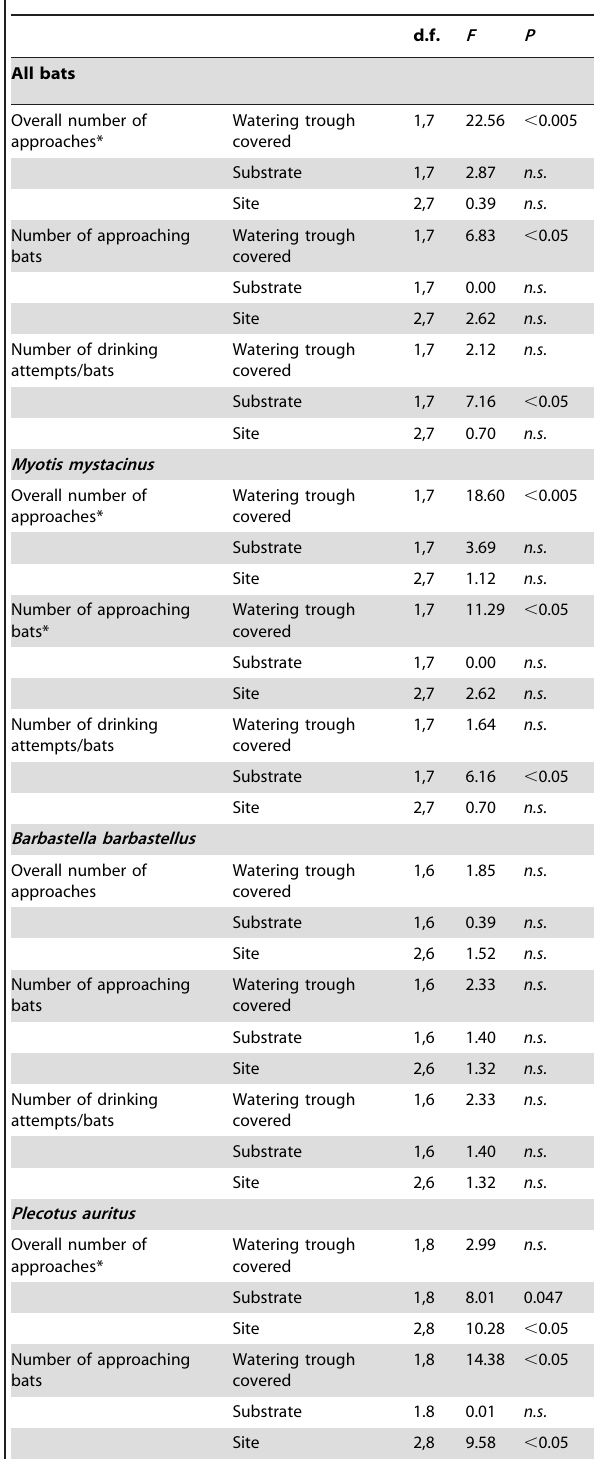
Table 1. Results of repeated measures General Linear Model ANOVA for the effect of watering trough covered, substrate type – water or Perspex – and site, on: a) the total number of drinking approaches to either surface (Perspex vs. water); b) the number of individual bats performing them; and c) the number of approaches per